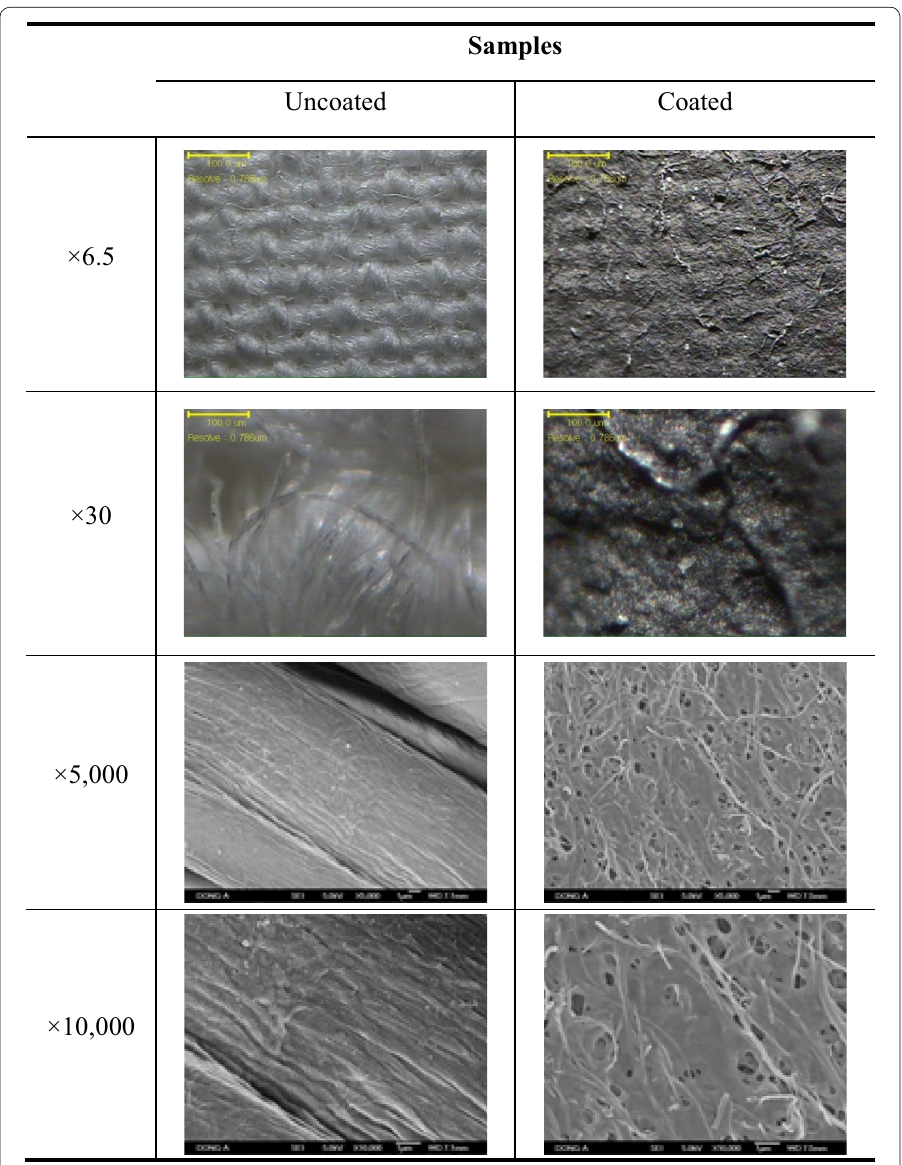
Fig. 2 Surface morphology of the CNF/PVDF-HFP composite coated on cotton